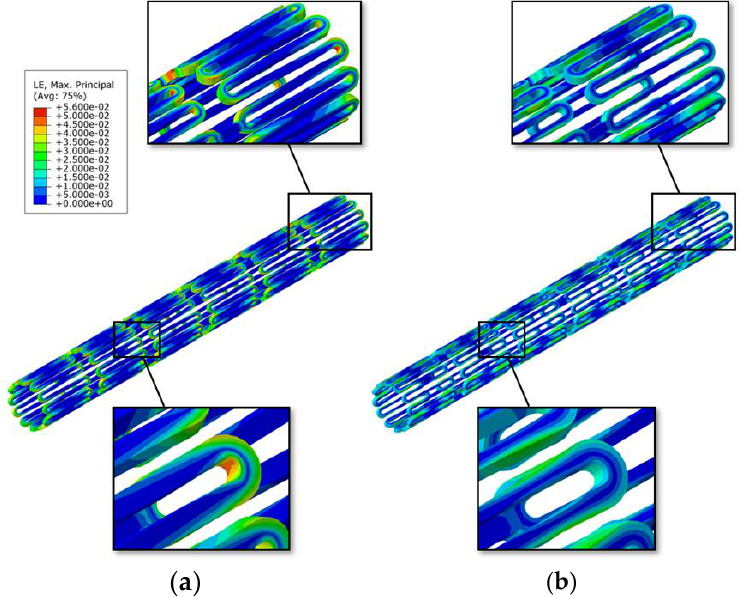
Figure 10. Contour plot comparison of strain distribution between a standard design ( a ) and a 40% tapered-strut design ( b ).